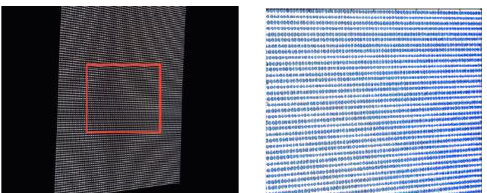
Figure 8. Pictures of right camera (Red box in the figure is the window).